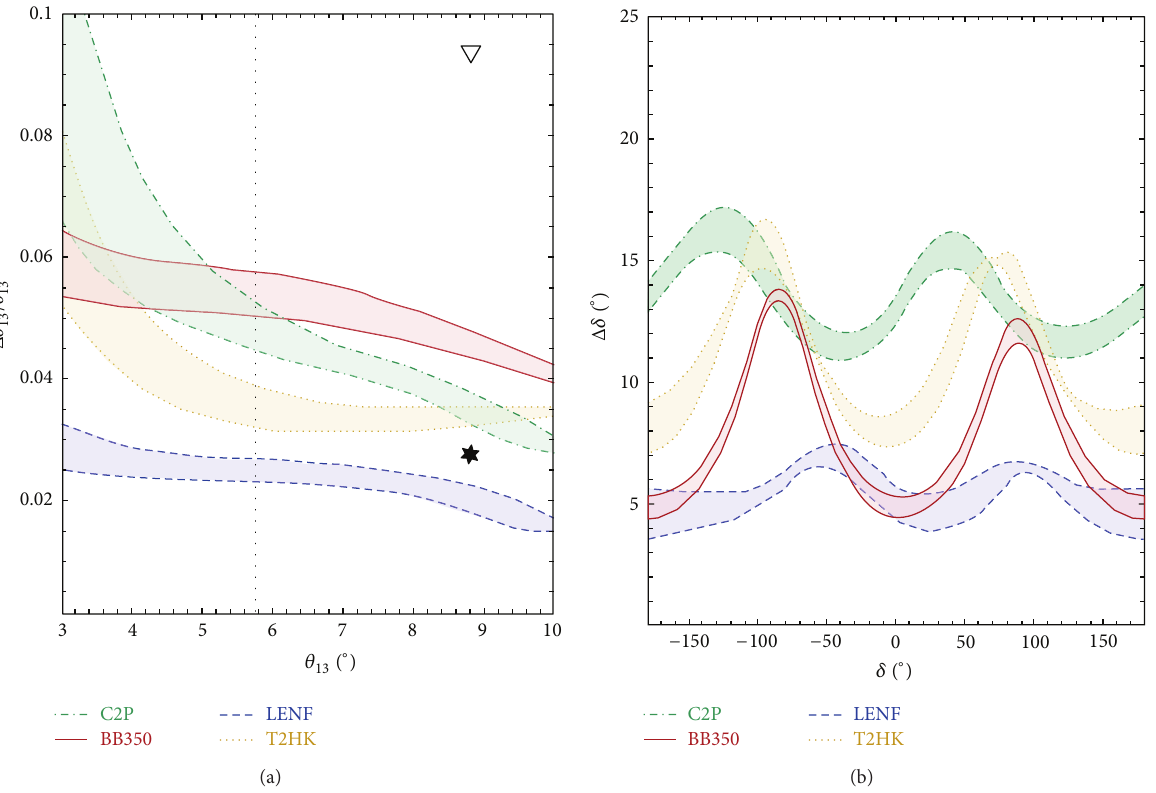
Figure 21: 1𝜎 precision on 𝜃 13 (a) and 𝛿 (b) for the CN2PY and T2HK superbeams, the 𝛾 = 350 beta-beam, and the LENF. On the left plot, the empty triangle represents the current precision for Daya Bay, and the star the ultimate attainable precision, assuming as true value the present Daya Bay best fit value. The width of the bands represent the dependence of the error on 𝜃 13 on 𝛿 and vice versa. For further details, see [46] from which the figure is